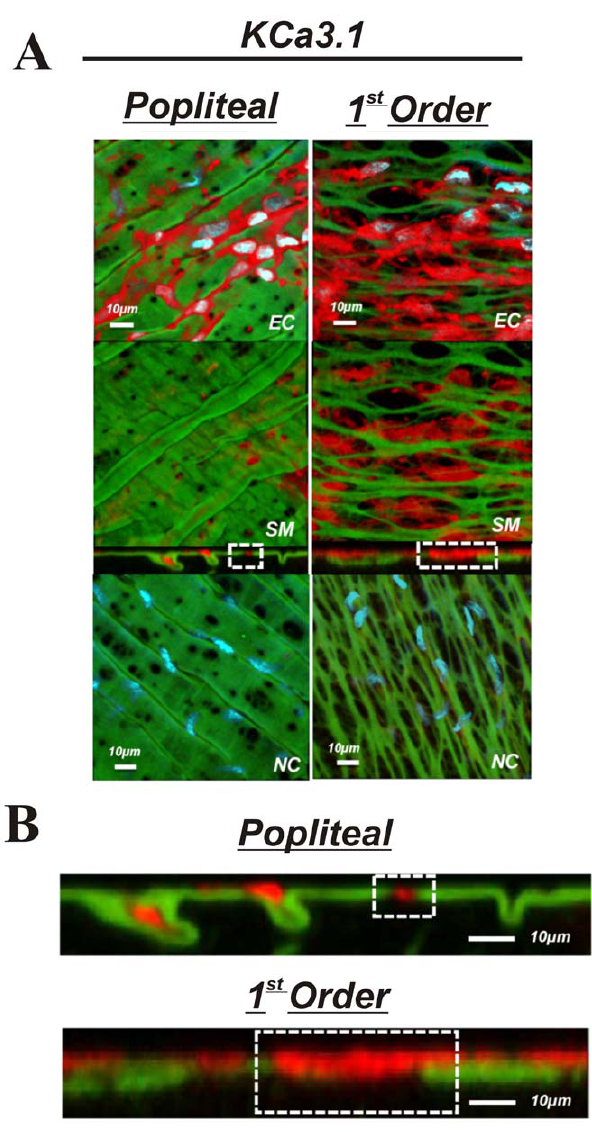
Figure 6. KCa3.1 in skeletal muscle arteries. A: skeletal muscle popliteal (left) and 1 st order (right) arteries immunolabeled for KCa3.1 (top 3 panels) or no primary antibody control (bottom panel). The top image represents a composite of DAPI-stained nuclei in the endothe- lium, autofluorescence of the internal elastic lamina (green), and KCa3.1 immunolabeling immunolabeling (red), and a compressed z-stack image endothelial cell surface (EC, top panel). The second image is a compressed z-stack image from the perspective of the smooth muscle face (SM), the third image is a cross-sectional slice, and the fourth is a compressed z-stack image of a no primary antibody control (NC).Red staining indicates endothelial expression of KCa3.1. B: Magnified image of the cross-sectional view of the IEL. Note the sections highlighted by dotted square boxes indicating larger MEC and area of KCa3.1 staining in 1 st order arterioles. Bar=10 m m. Representative of images from tissue isolated from at least 3 animals.